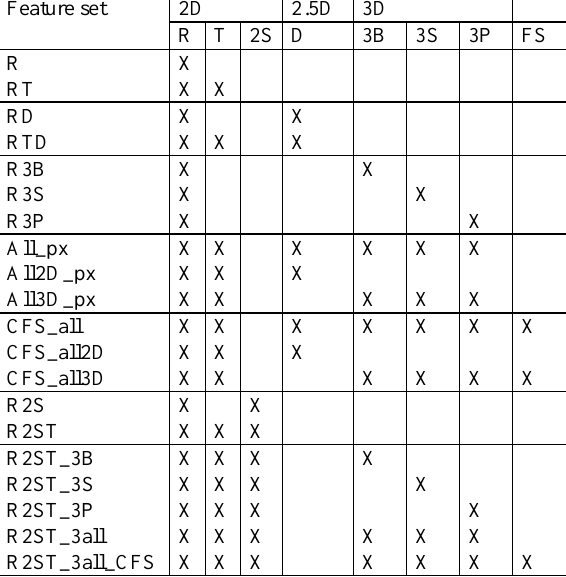
Table 3. Description of the feature sets used for the classification experiments. See Table 2 for a description of the feature set codes, FS indicates feature selection was